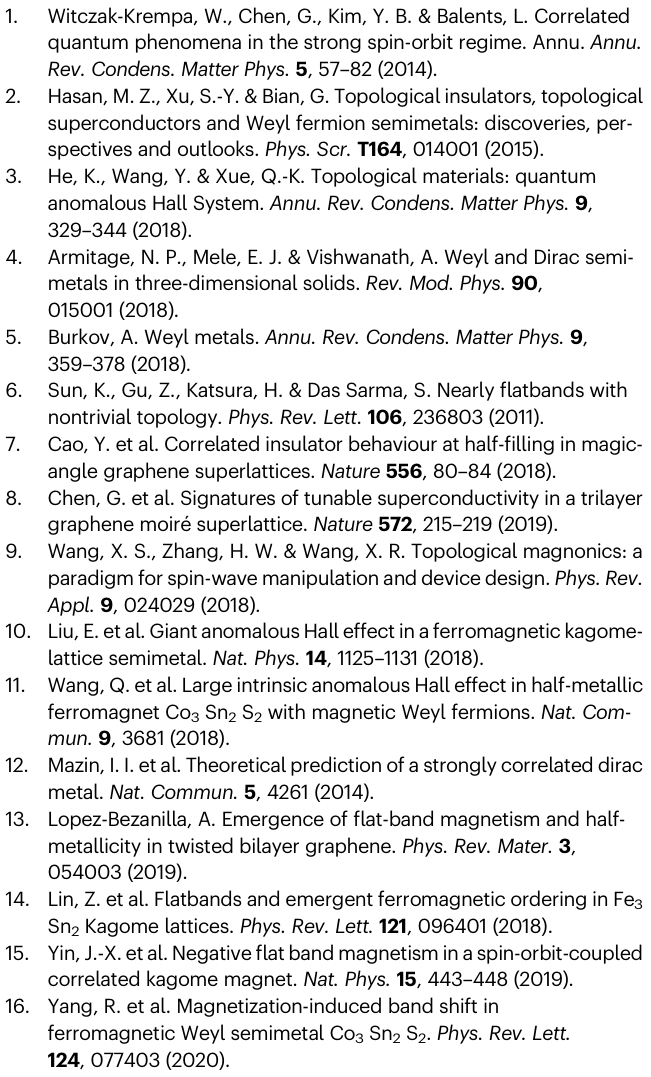
hexagonal lattice constants a = b = 5.3689 Å and c = 13.176 Å was used in the calculations.